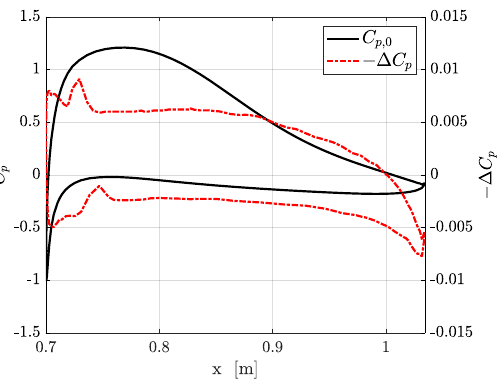
Figure 8. Pressure coefficient on the pressure and suction sides of the isolated UAV wing at 2 y / b = 0.52, at α = 4 ◦ , for the clean case (black line) and difference with the riblets case (red dashed